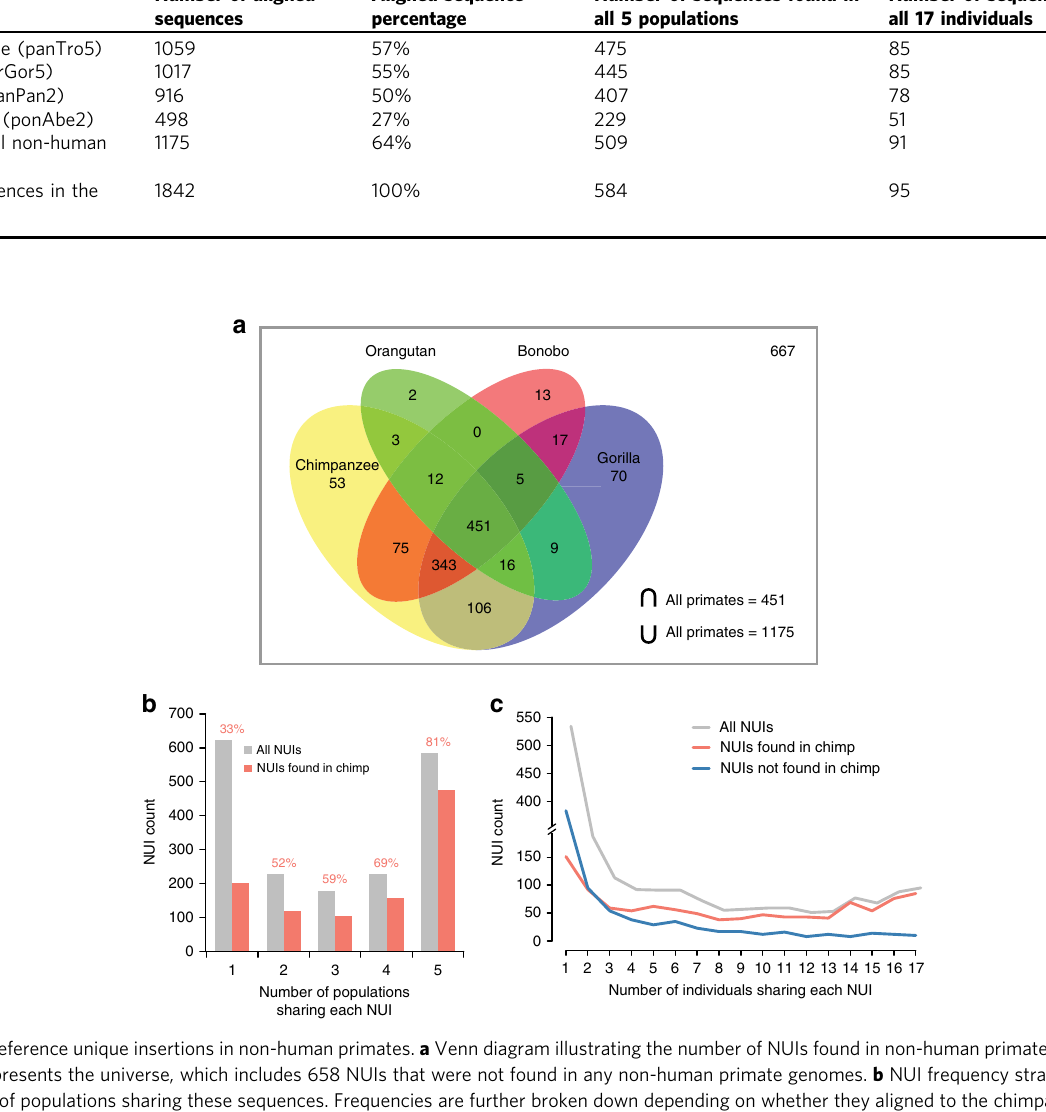
Number of sequences found in all 5 populations